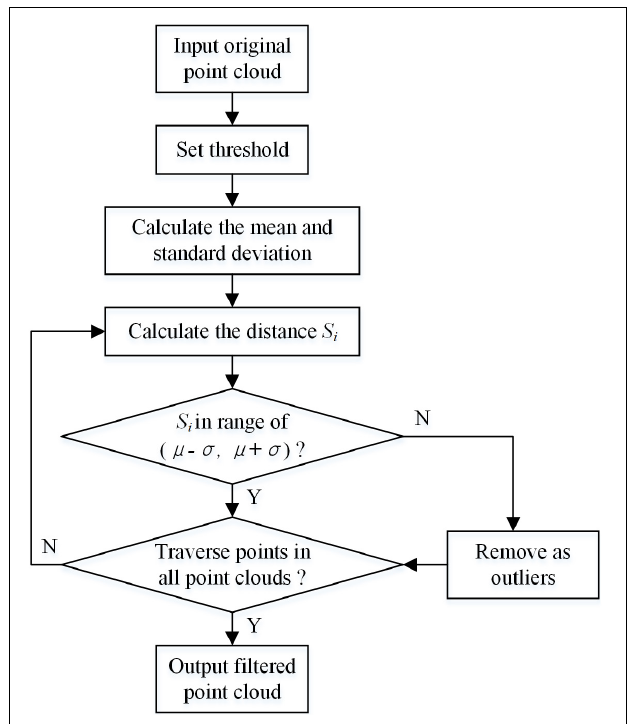
FIGURE 4 | Flowchart of statistical